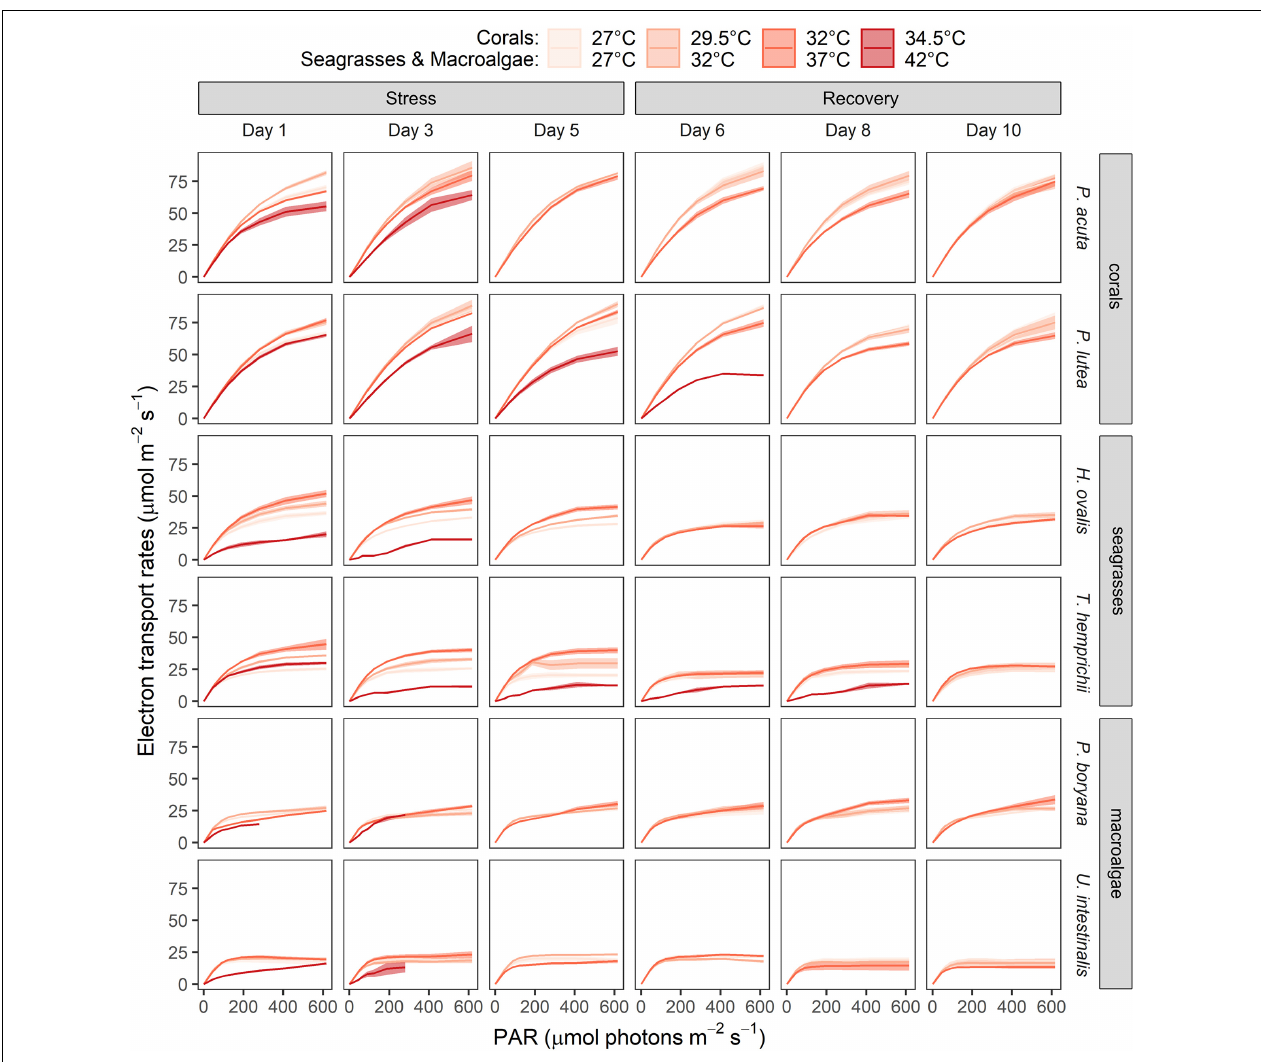
FIGURE 3 | Time course of the warming effects on the rapid light response curves of corals, seagrasses and macroalgae. Values are shown as mean ± SE ( n = 3). For each replicate, 3 individuals were assessed. Corals were subjected to 27–34.5 ◦ C in stress period and 27 ◦ C in recovery period. Seagrasses and macroalgae were subjected to 27–42 ◦ C in stress period and 32 ◦ C in recovery